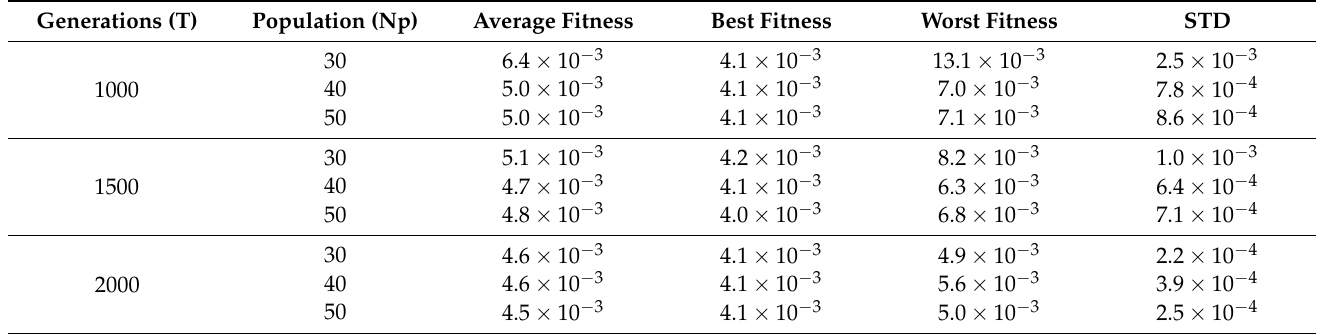
Table 14. AO analysis with respect to generation and population sizes at 0.08 noise variance.